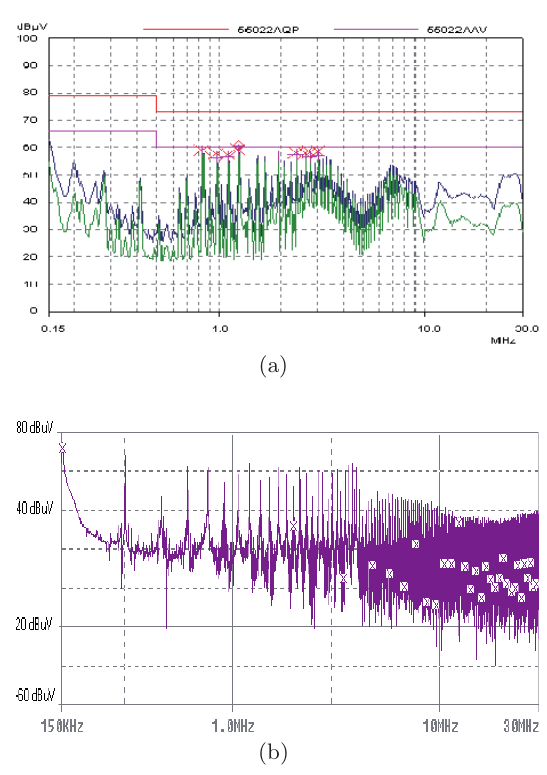
Fig. 7. Illustration of the second resonance pick suppression results from the input lines. (a) Measured conducted EMI re- sults. (b) Simulation conducted EMI